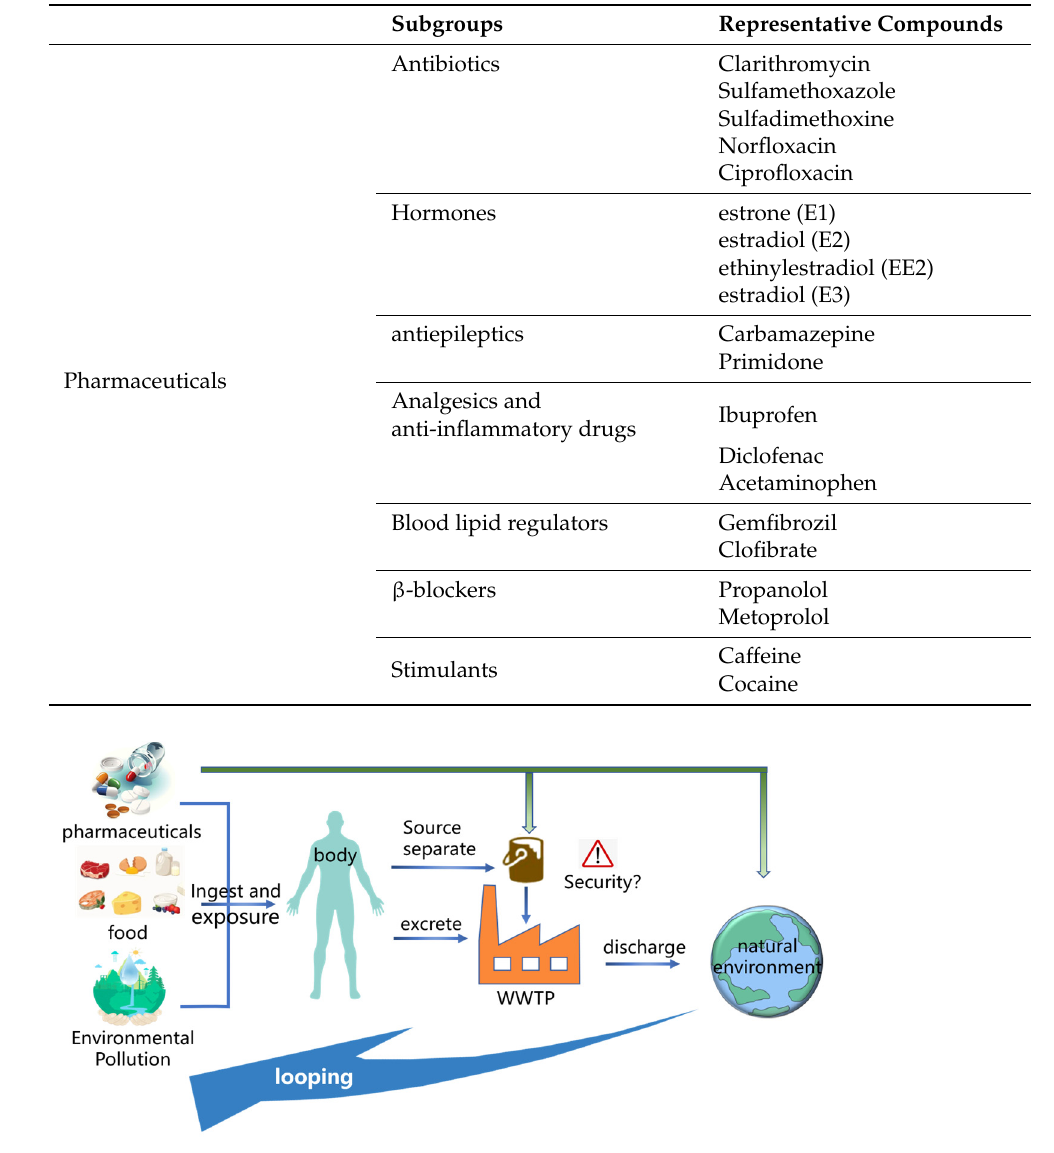
Figure 1. Sources of pharmaceutical contaminants in the environment .